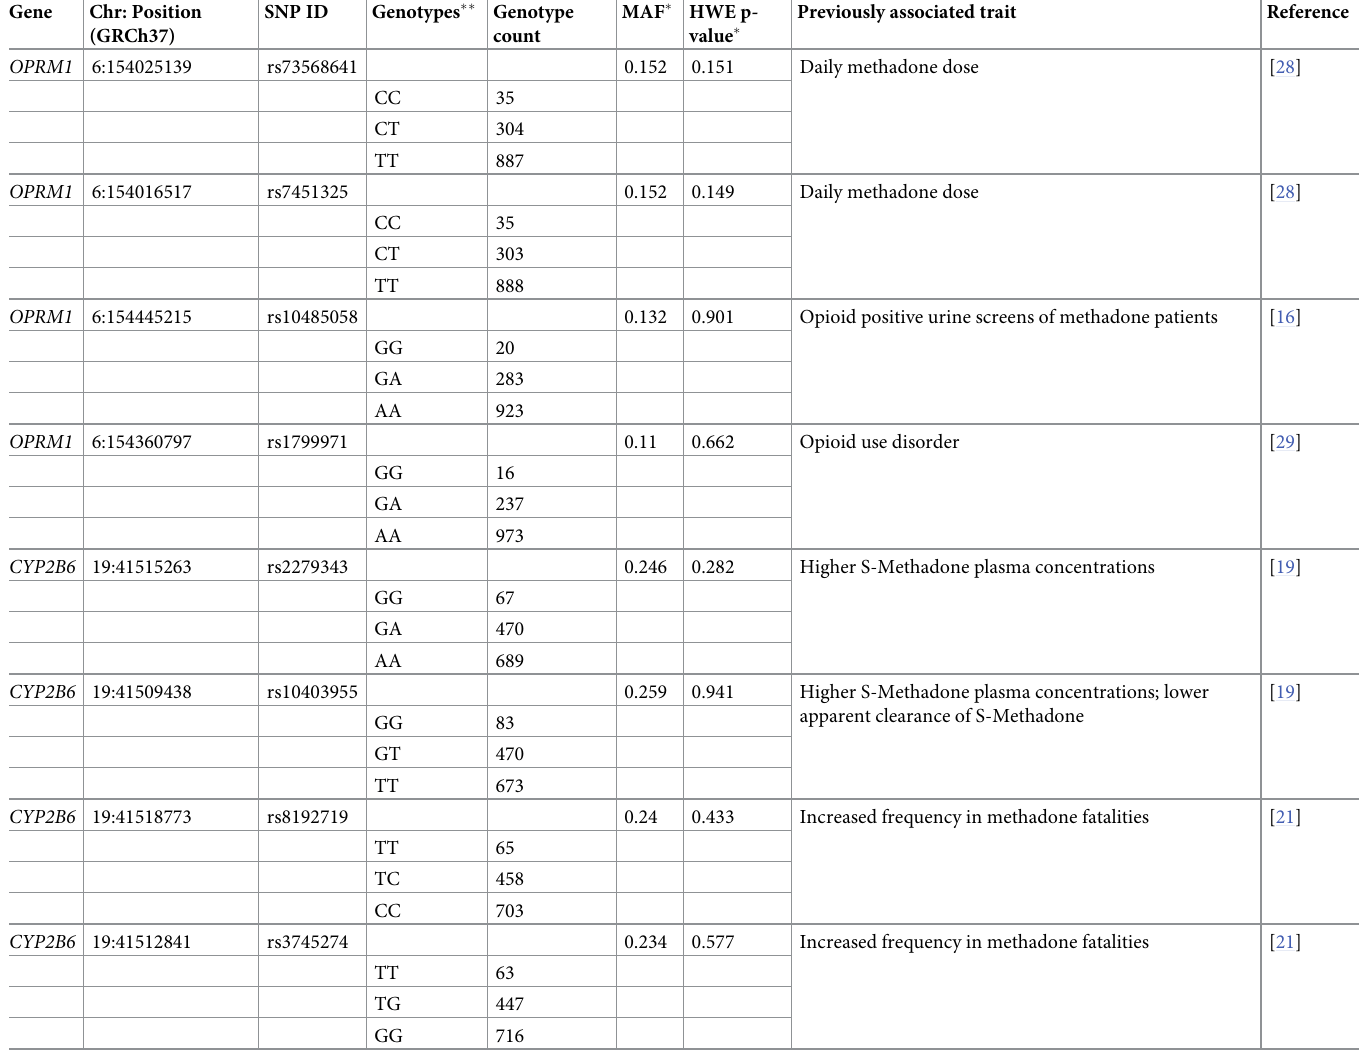
MAF = minor allele frequency. HWE = Hardy-Weinberg equilibrium. � Data from the GENOA study (N = 1226). �� Alleles are on the +